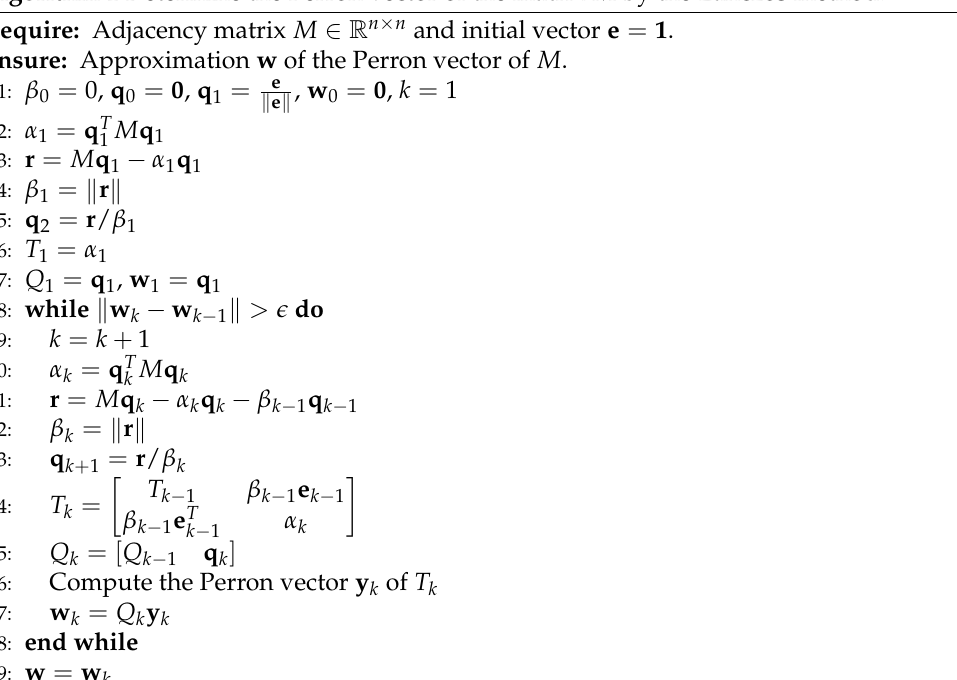
Algorithm 1 Determine the Perron vector of the matrix M by the Lanczos